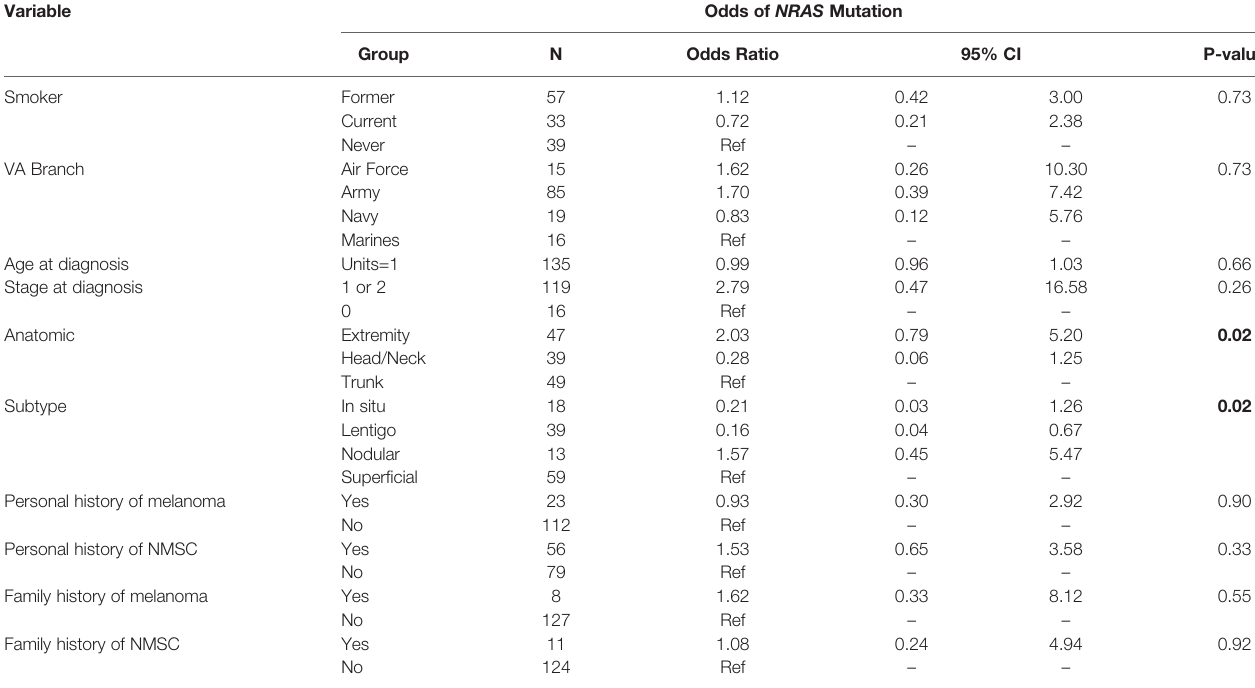
TABLE 5 | Univariate analysis between demographic and clinical factors and NRAS